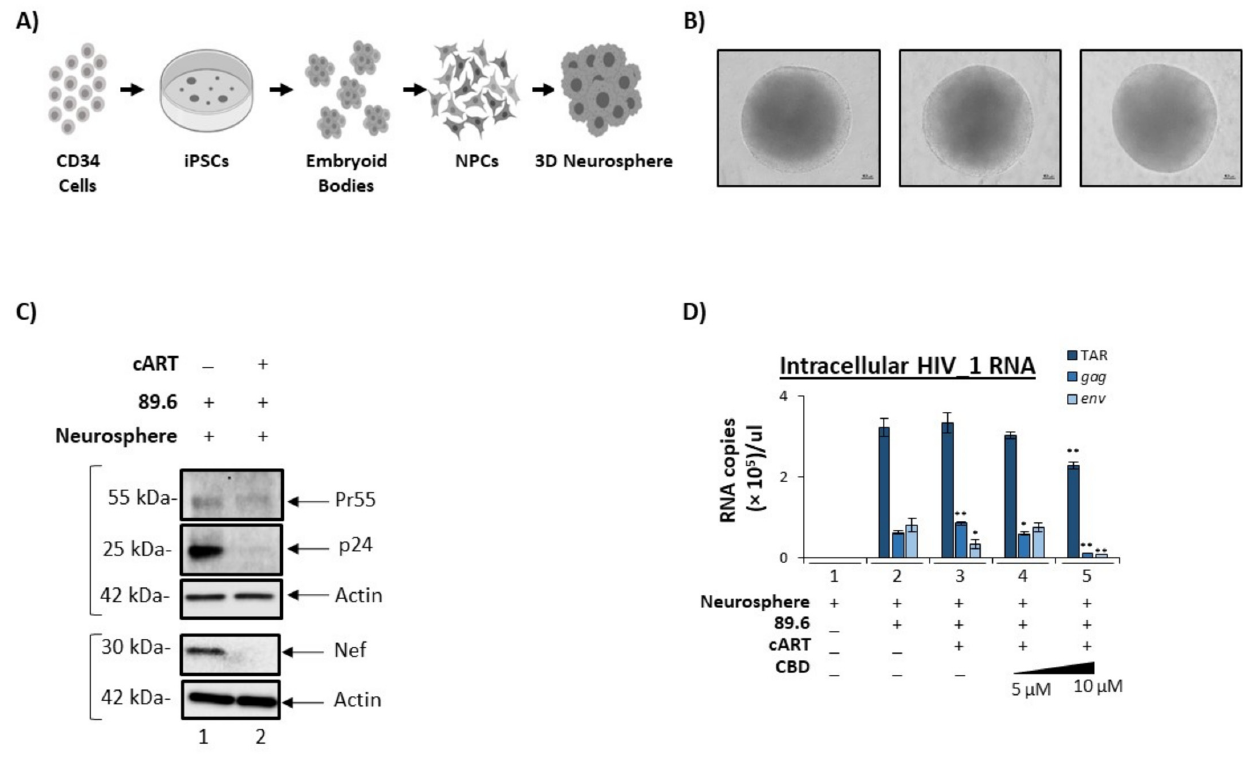
Figure 6. CBD lowers viral transcripts in 3D neurospheres. ( A ) Differential workflow of 3D neu- rospheres. ( B ) Phase-contrast microscopic images of three 3D neurospheres taken where scale bar = 100 µ m. ( C ) 3D neurospheres were treated with HIV-1 89.6 (MOI: 10) viral strain ± cART (10 µ M; Tenofovir, Emtricitabine, Lamivudine, and Indinavir), incubated for 7–14 days, harvested and lysed. Samples were run through SDS-PAGE and Western blotted for viral proteins (Pr55, p24, Nef and Actin). For Nef Western blot, samples were run on a different gel and also probed for actin. ( D ) 3D neurospheres were treated ± 89.6 viral strain ± cART (10 µ M; Tenofovir, Emtricitabine, Lamivudine, and Indinavir) ± CBD titration (5 and 10 µ M) and incubated for 7 days. RNA was isolated from the 3D neurospheres and supernatants, followed by RT-qPCR analysis for viral RNA transcripts TAR, TAR-gag, env. Student’s t -test was used for statistical analysis, where * = p < 0.05, ** = p <